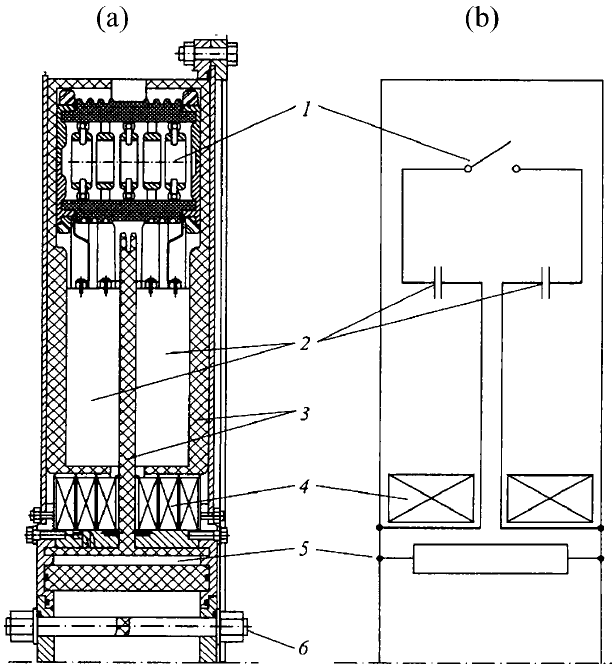
FIG. 2. (a) Side section of a brick with a liquid resistor as a load. This is an actual reduction of the cavity assembly blueprint. (b) Schematic electrical diagram of the brick. The cavity com- ponents are: 1—switch; 2—capacitors; 3—plastic insulator plates; 4—ferromagnetic cores; 5—annular KBr liquid resistor load; 6—supporting nylon